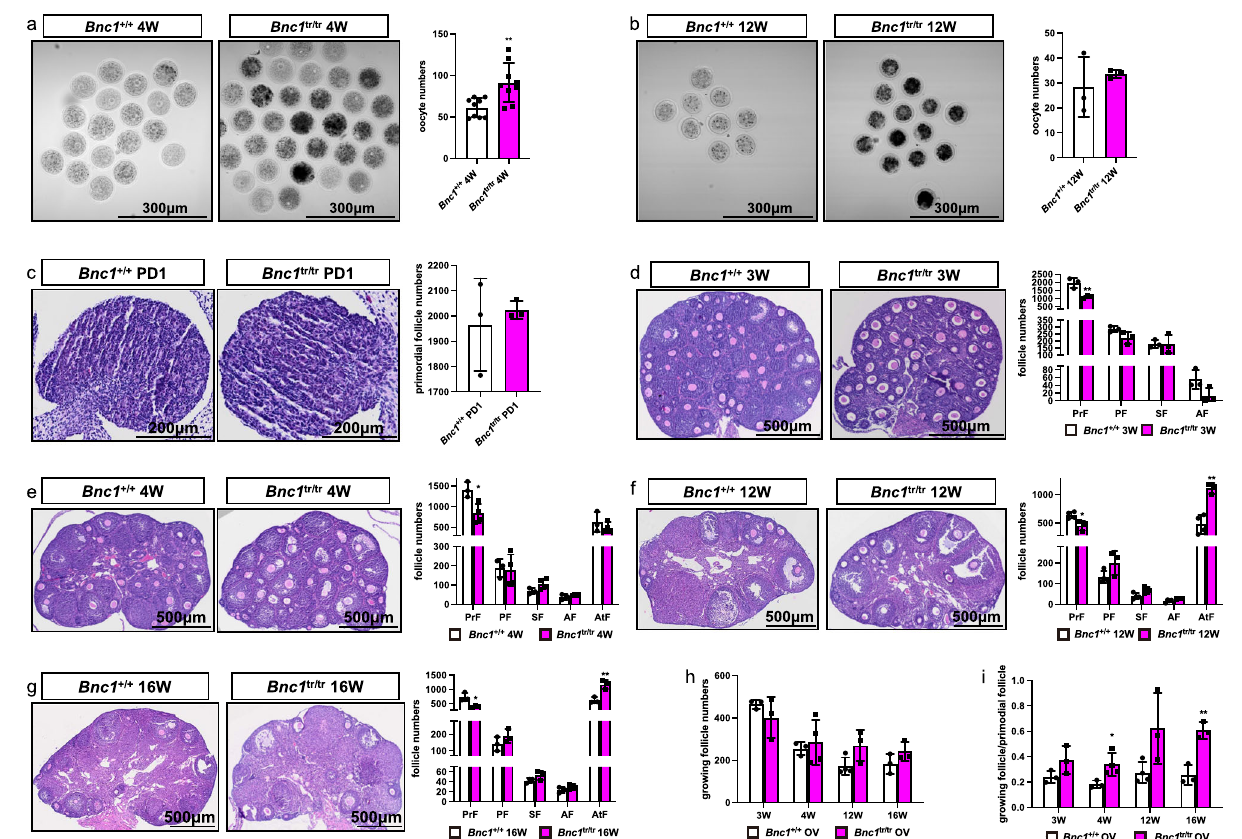
Fig. 1 | Bnc1 mutation affects follicle development. a GV oocytes from Bnc1